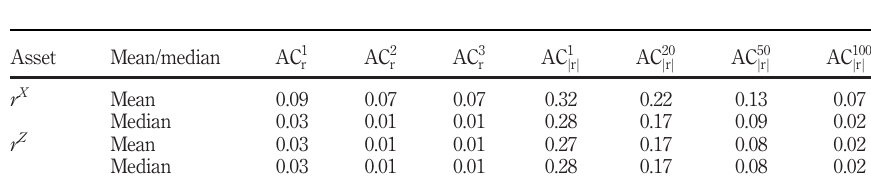
Table IV. Autocorrelations for raw and absolute returns of both markets